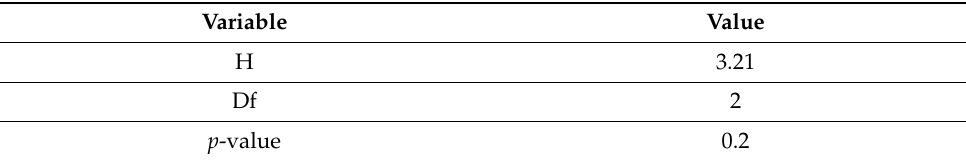
Table 4. Result for usability evaluation—Kruskal–Wallis Test.